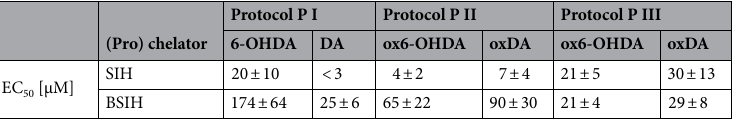
Table 1. Comparison of protective effects of Fe chelator SIH and its derived prochelator BSIH against toxicities of catecholamines 6-hydroxydopamine (6-OHDA) and dopamine (DA) and 24 h-preincubated catecholamines (ox6-OHDA, oxDA) using various experimental protocols and LDH assay. Protocol P I —the (pro)chelator was co-incubated for 24 h with freshly-prepared catecholamine; Protocol P II —the cells were incubated with studied (pro)chelator added just before cellular experiments to medium with 24 h-preincubated (i.e., oxidized) catecholamines; Protocol P III : cells were incubated with studied compounds added to the medium at the beginning of catecholamine 24 h-preoxidation. EC 50 values [µM] are calculated concentrations of (pro) chelator at which it reduces the toxicity of catecholamine to 50%.